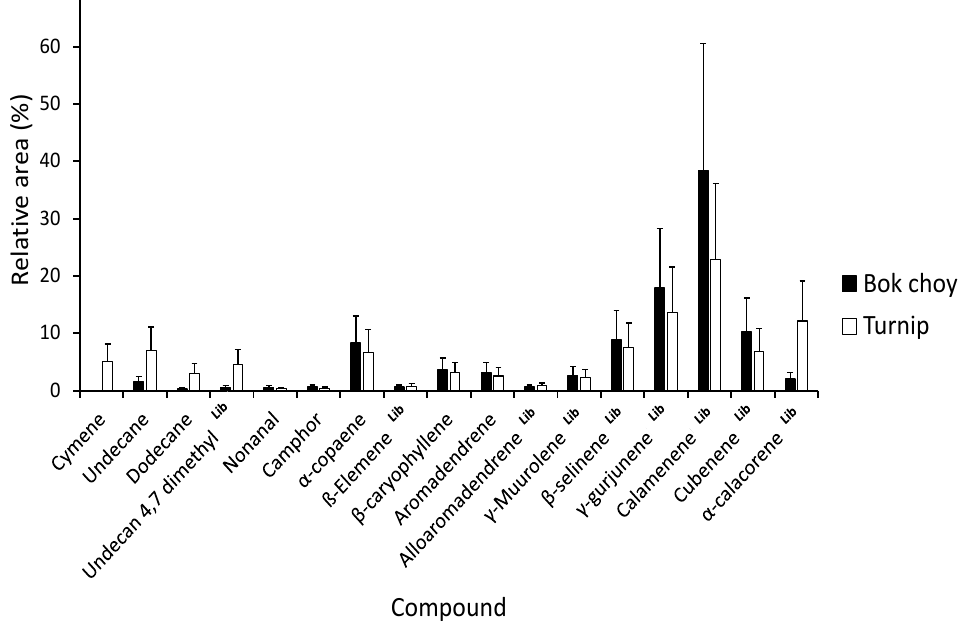
Figure 6. Mean ( ± SE) relative area for the 17 compounds in volatiles from powdered bok choy and turnip leaves. Compounds are presented in the order of elution. Lib (superscript) indicates compounds identified based on libraries only, as standards were not available.